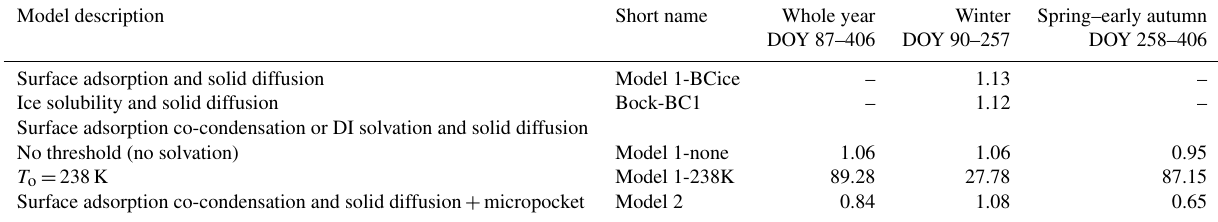
Table 3. Summary of model performance at Halley based on the coefficient of variation of RMSE, C v (RMSE). Model description